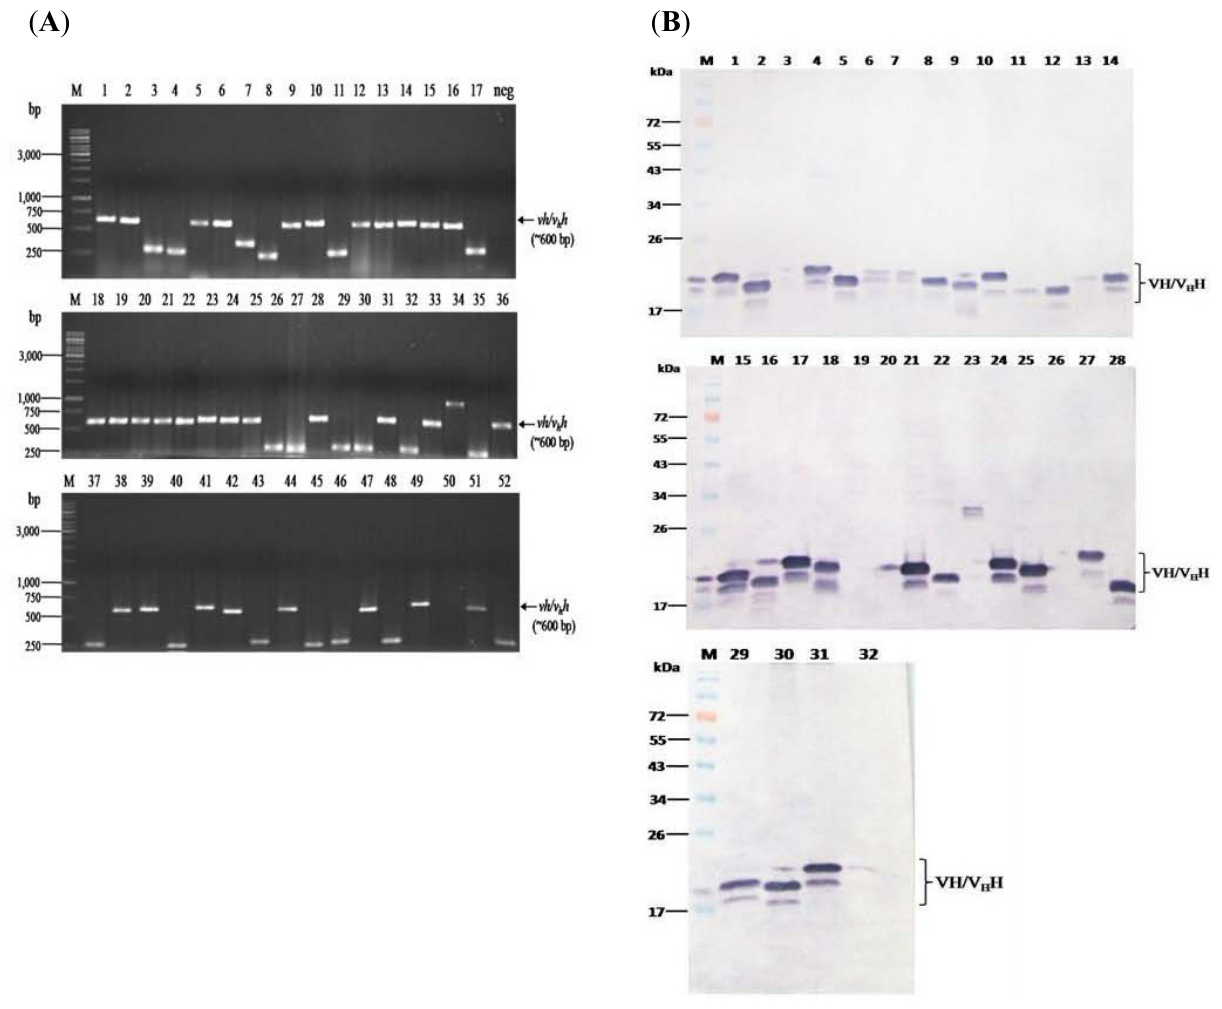
Figure 2. Amplicons of humanized- vhs/v h hs in the HB2151 E. coli clones transfected with the NS3/4A-bound phages and the VHs/V H Hs contained in the E. coli lysates revealed by Western blot analysis. ( A ) Results of PCR amplification of vhs/v h hs using 52 randomly picked phage transformed HB2151 E. coli colonies as templates and R1 and R2 primers. The expected size of vh/v h h sequences including flanking region of phagemid was  600 bp (arrows). Lane M of all three blocks, GeneRuler TM 1 kb DNA ladder; lanes 1, 2, 5, 6, 9, 10, 12–16, 18–25, 28, 31, 33, 36, 38, 39, 41, 42, 44, 47, 49 and 51 were 32 E. coli clones that were positive for the vh/v h h amplicons; lane neg, negative control (PCR mixture without DNA template). Numbers at the left of all blocks are DNA sizes in base pairs (bp); ( B ) Western blot results for detecting the VHs/V H Hs in lysates of the 32 E. coli clones that carried the vhs/v h hs . Lane M, Pre-stained standard protein ladder; lanes 1–2, 4–18, 21–22, 24–25 and 27–32 show VHs/V H Hs (  19–22 kDa) expressed from 28 clones; lane 3, 19, 23 and 26 were lysates of vh/v h h- positive E. coli clones that did not express VHs/V H Hs. Numbers at the left of all blocks are protein molecular sizes in